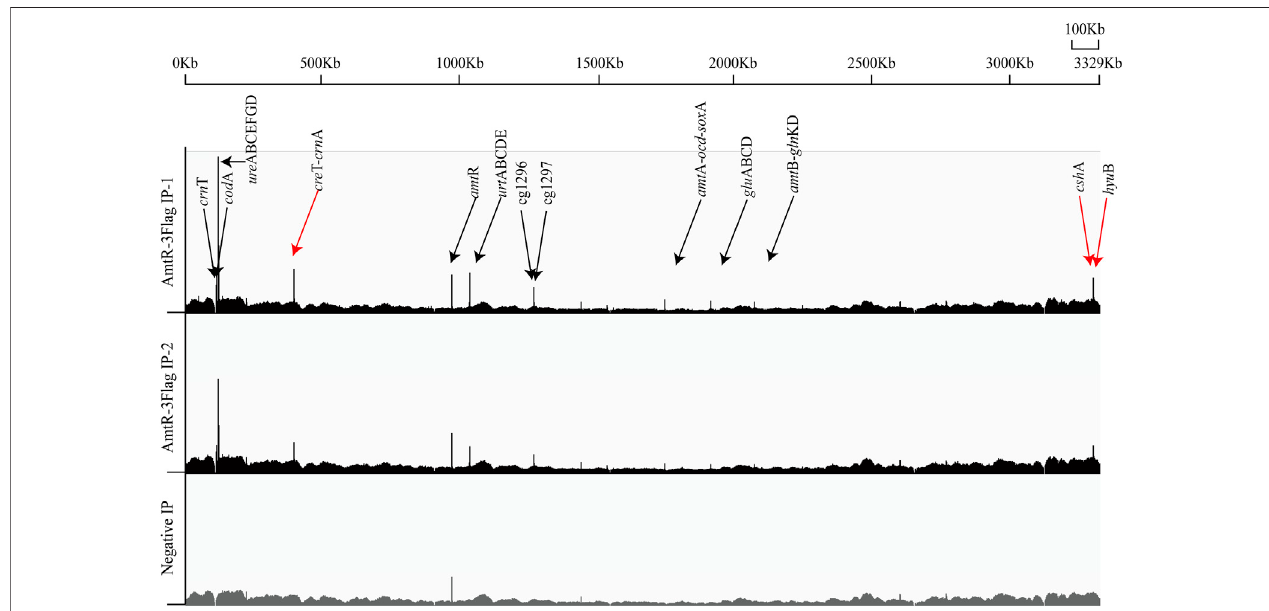
FIGURE 1 | Genome-wide in vivo identi fi cation of the AmtR binding sites in C. glutamicum ATCC 14067. AmtR-3Flag IP reads were plotted against the number of reads from theNegative IP.Black arrows show the veri fi edgenes;red arrows show the new target genes. In AmtR-3FlagIP,AmtR-3Flag production wasinducedusing 0.5 mM IPTG for 8 h; AmtR-3Flag production was not induced with 0.5 mM IPTG as the negative